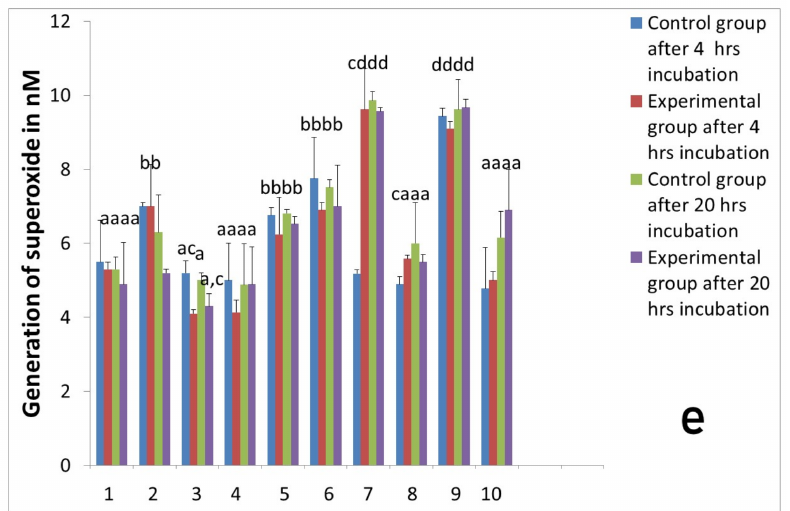
Figure 4. The response of neutrophils isolated 2 h after implantation with different PRP-derived products with or without additional stimulation with LPS. Cultures were incubated for 4 h or for 20 h at 37 °C and 5% CO 2. Data present mean values ± SE of at least three replicates for each bar. The neutrophil response was assessed with respect to: ( a ) elastase release from neutrophils, ( b ) MPO release, ( c ) ALP release, ( d ) NO generation, ( e ) superoxide generation. Values marked with different letters differed significantly ( p < 0.05). Legends: 1—neutrophil without stimulation, 2—after stimulation LPS, 3—after stimulation PPP from L-PRP, 4—after stimulation PPP from PURE PRP, 5—after stimulation PPP from L-PRP with LPS, 6—after stimulation PPP from PURE PRP with LPS, 7—after stimulation L-PRP, 8—after stimulation PURE PRP, 9—after stimulation L—PRP with LPS, 10—after stimulation PURE PRP with LPS.